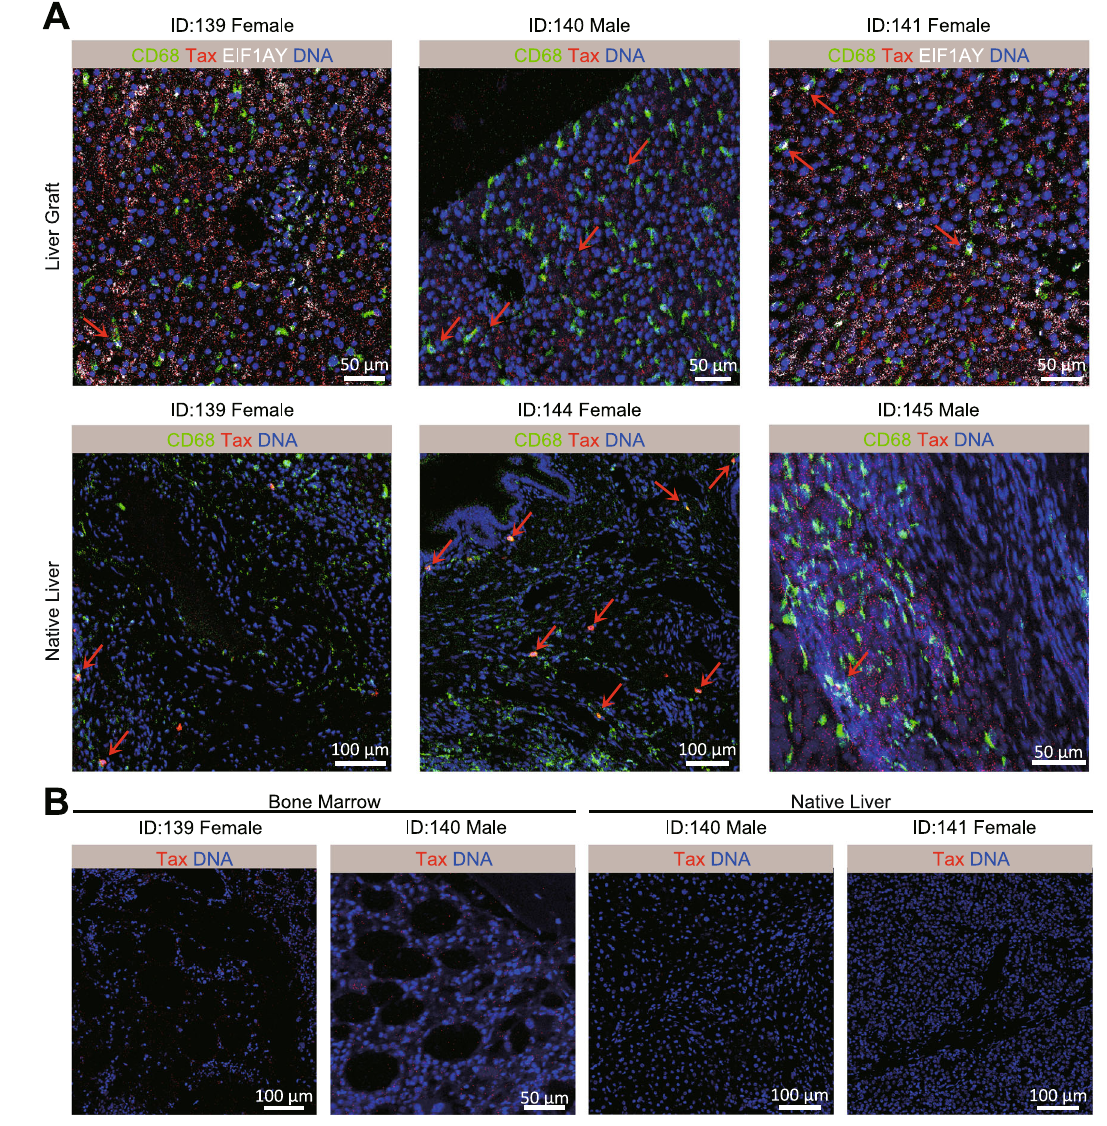
Fig. 6 | HTLV-1 speci fi c Tax protein detected on liver graft, native liver, and bone marrow samples from aGVHD patients by IMC. A Representative Tax + images of two independently stained liver graft and native liver show two overlap patterns. Each row of fi gures display the same tissue type. Displayed channels for liver graft samples from left to right are: CD68 (green)/Tax (red)/EIF1AY (white)/ DNA (blue), CD68 (green)/Tax (red)/DNA (blue), CD68 (green)/Tax (red)/EIF1AY